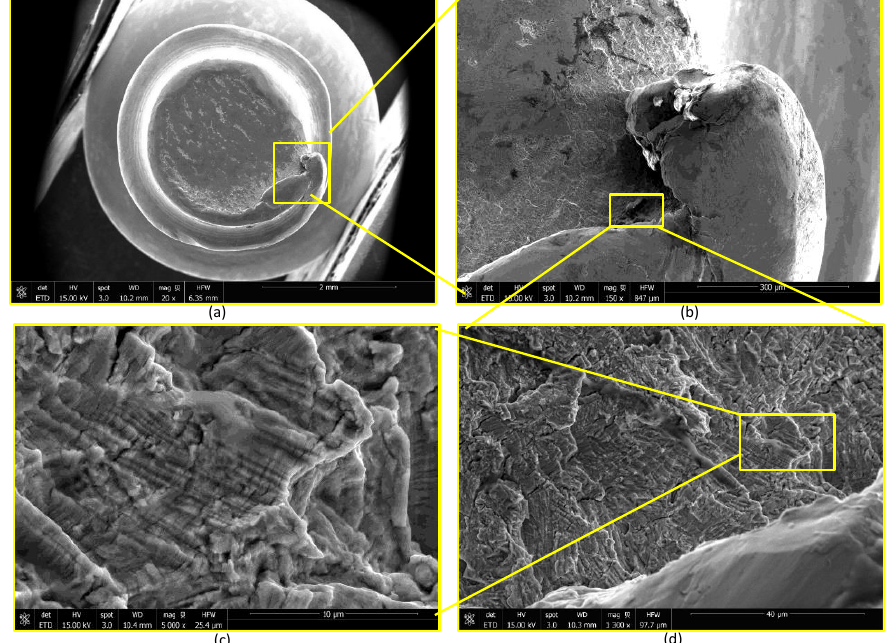
Figure A6. ( a ) Montage of SEM images showing the fracture surface of the cannulated screw, ( b – d ) dimples/overloading.